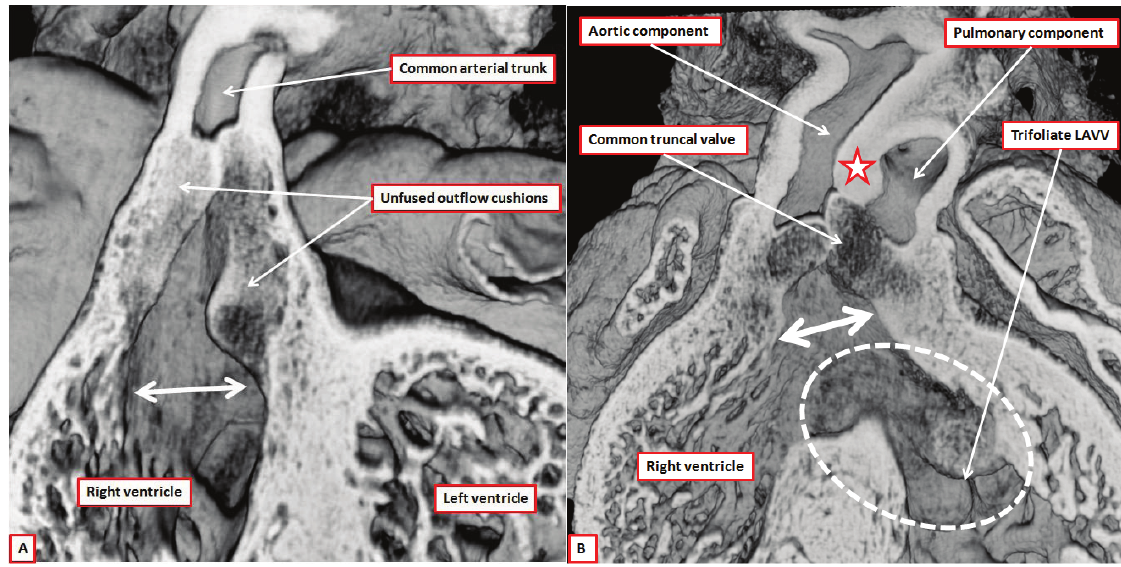
Figure 15. The images are taken from episcopic datasets prepared from mice with, in panels ( A ) and ( C ), knock-out of the Tbx1 gene, and in panel ( B ), floxed perturbation of the furin enzyme. The images are shown solely to demonstrate the failure of fusion of the outflow cushions (Panels ( A ) and ( B )), and the consequence for formation of the leaflets of the common truncal valve (Panel ( C )). The hearts from the mice null for the Tbx1 gene were both obtained at E12.5. As is seen in panel A, the major cushions remain unfused thoughout the length of the outflow tract, with preservation of an extensive length of muscular inner heart curve (double headed white arrow). The undivided outflow tract is supported exclusively by the developing right ventricle. In the heart from the mouse with the perturbed furin enzyme, obtained at E14.5, there has been separation of the distal outflow tract by growth of the aortopulmonary septum (star), with balanced arrangement of the pulmonary and systemic components of the distal outflow. There remains a common muscular infundibulum, with lack of fusion of the proximal outflow cushions (double headed white arrow), but there is also a common atrioventricular junction (white dashed oval). Shunting across the atrioventricular septal defect, however, is exclusively at ventricular level. Note the trifoliate arrangement of the left ventricular component of the atrioventricular valve (LAVV). Panel ( C ) is a short axis section of the undivided outflow tract viewed from above in the Tbx1 null mouse. There are three major cushions, the putative pulmonary intercalated cushion being grossly